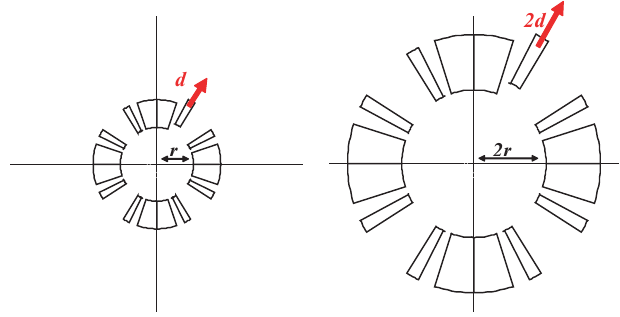
FIG. 4. (Color) Rescaling of a coil layout and of a block dis- placement by (cid:5) (cid:5) 2 , leading to the same multipolar errors.